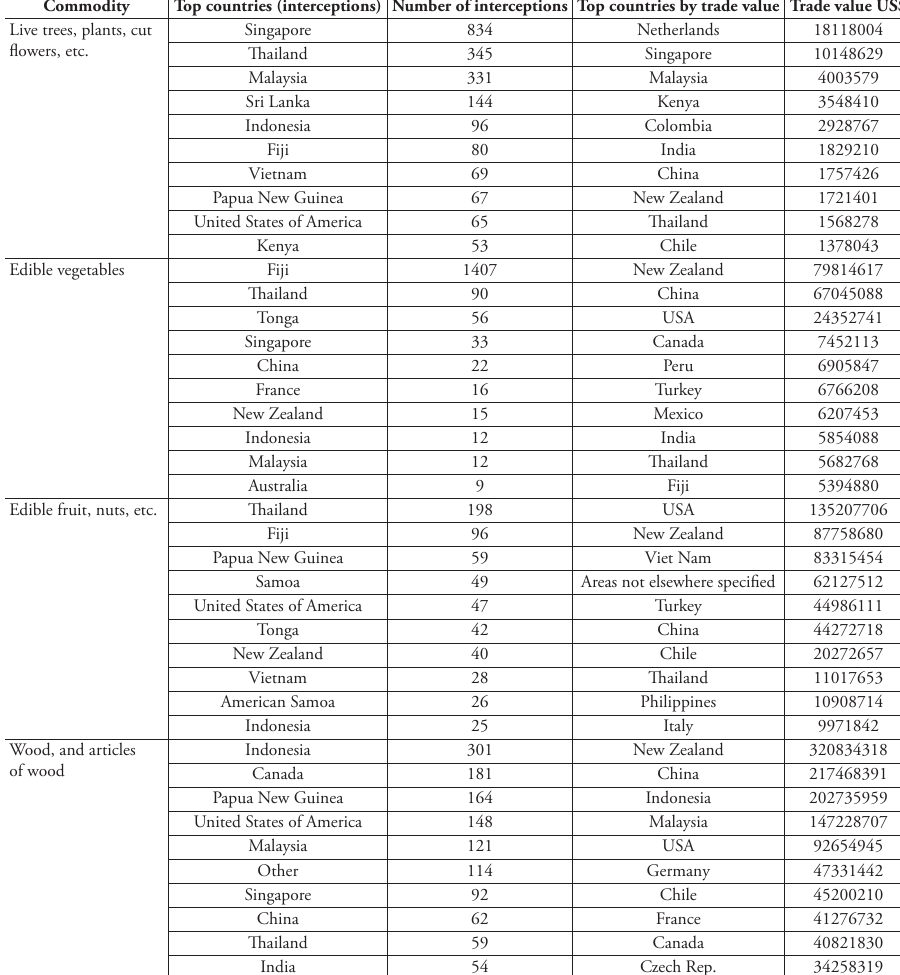
Table 3. For the four commodity groups associated with most ant interceptions into Australia, the top ten countries of origin ranked by number of ant interceptions (left column) or the overall value of the imported commodity (right column). Top countries (interceptions) Number of interceptions Top countries by trade value Trade value US$ Live trees, plants, cut flowers,